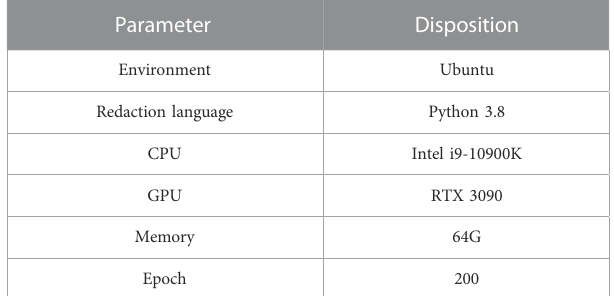
TABLE 1 The parameters of